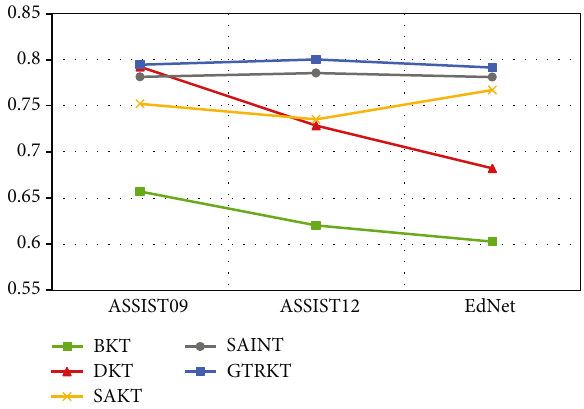
Figure 6: Comparison of di ff erent model.